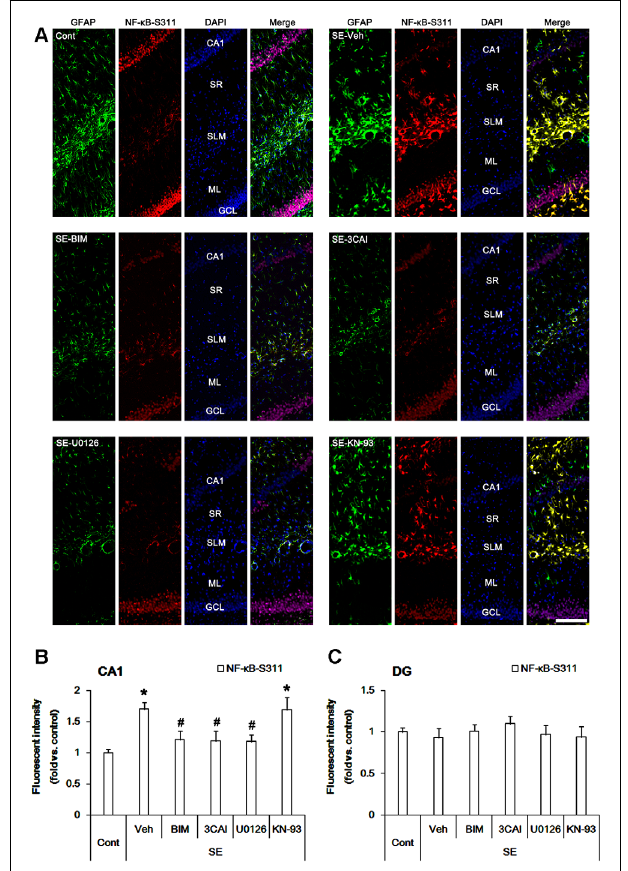
FIGURE 4 | Alterations in NF- κ B-S311 phosphorylation in the hippocampus following SE. SE increases NF- κ B-S311 phosphorylation in CA1 astrocytes, which is attenuated by BIM, 3CAI, and U0126, but not KN-93. SE does not influence NF- κ B-S311 phosphorylation in dentate astrocytes. In addition, NF- κ B-S311 phosphorylation is unaffected by BIM, 3CAI, U0126 and KN-93. (A) Representative immunofluorescent images for GFAP and PEA15-S116 phosphorylation following SE. Bar = 100 µ m. Abbreviations: CA1, CA1 pyramidal cell layer; SR, stratum radiatum; SLM, stratum lacunosum-moleculare; ML, molecular layer; GCL, dentate granule cell layer. (B,C) Quantification of the fluorescent intensities